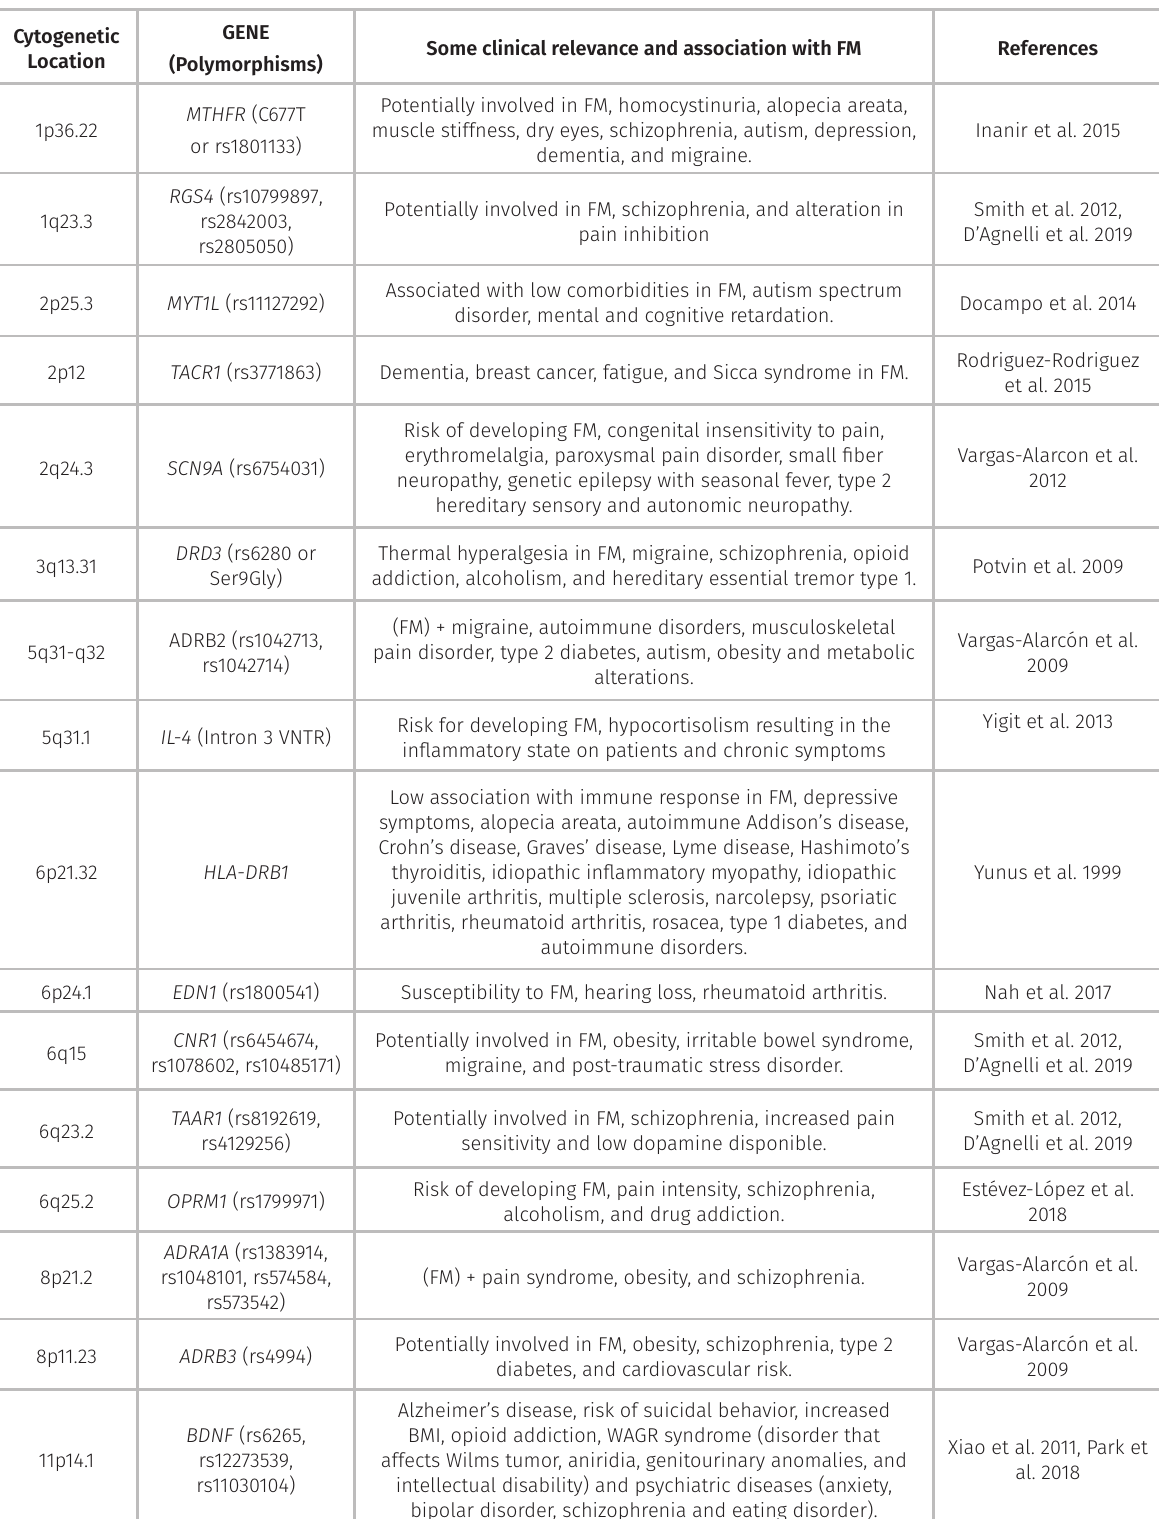
Table I. SNPs related to genes studied potentially involved in fibromyalgia’s pathogenesis. Cytogenetic